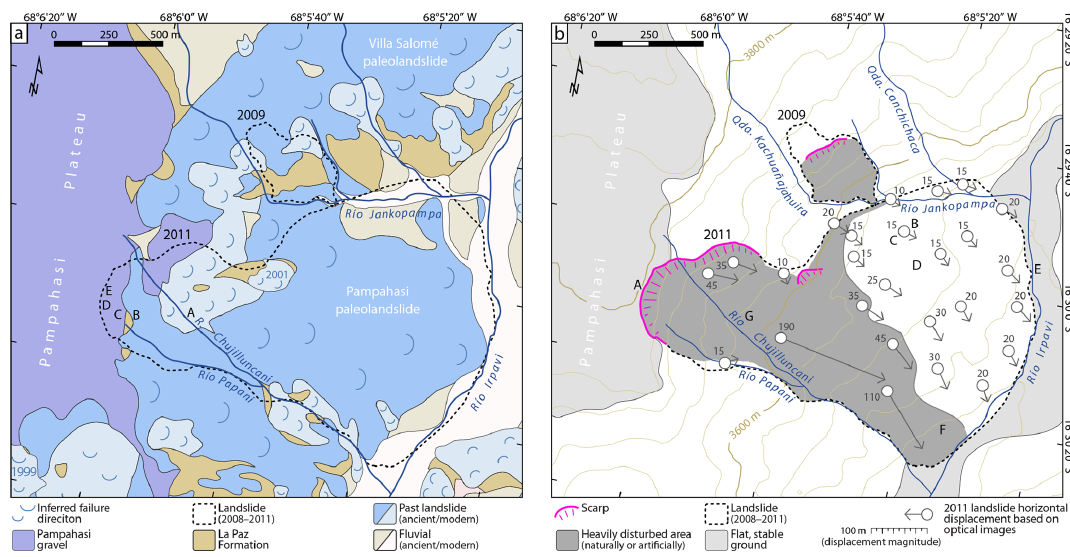
Figure 2. Ground surface conditions in the Pampahasi area. (a) Surficial geology prior to the start of the twenty-first century; adapted from Anzoleaga et al. (1977). (b) Slope morphology and ground disturbance showing the extent and morphologic features of landslides that occurred during the period of radar acquisition (September 2008 to December 2011). Horizontal displacements during the 2011 Pampahasi landslide are based on comparison of pre-failure and post-failure WorldView-2 scenes. Contours are from NASA’s Shuttle Radar Topographic Mission v3.0.